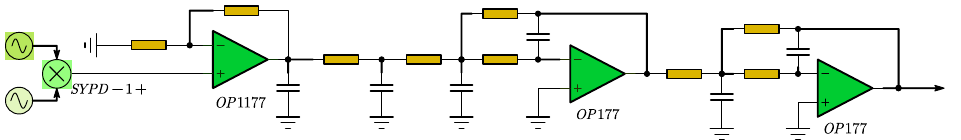
Figure 4. The circuit structure of the sinusoidal beat device module.